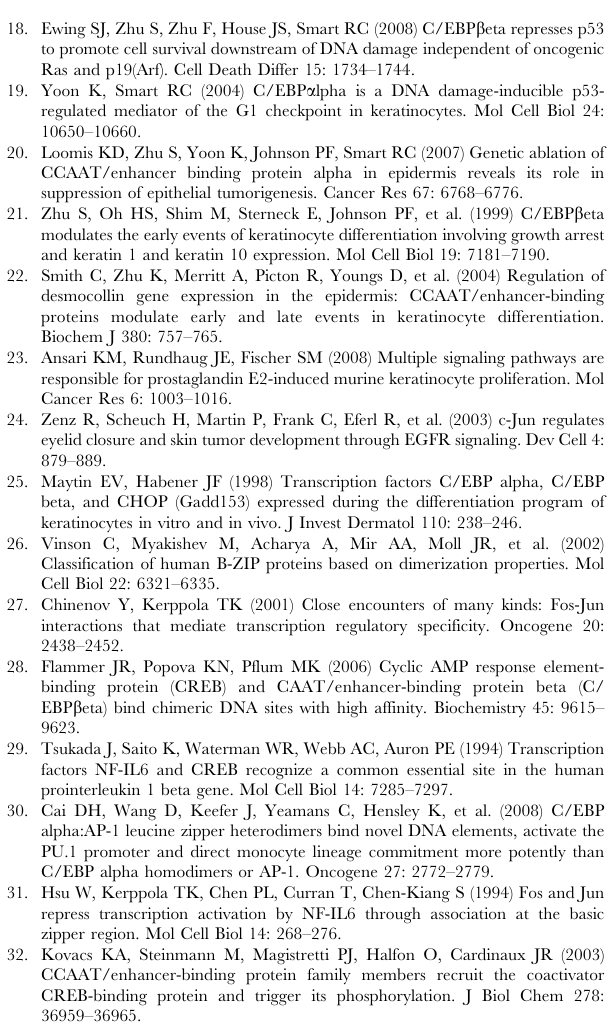
more than 1.4 times in groups of promoters bound by different combinations of transcription factors. * - values are different from expected (p , 0.05). E. Fraction of genes repressed by A-C/EBP differentiated keratinocytes in groups of promoters bound by different combinations of transcription factors. F. Fraction of genes repressed by A-Fos in differentiated keratinocytes in groups of promoters bound by different combinations of transcription factors * - numbers are different from expected (p , 0.001). Table S1 Numbers and fractions of promoters bound by different combinations of transcription factors and induced or repressed by differentiation. Reference groups used to calculate fractions in different groups are also presented. Above row 64 is the data for C/EBP b , CREB and c-Jun and below row 67 is the data for C/EBP a , CREB and c-Jun. paper: JMR RC KG